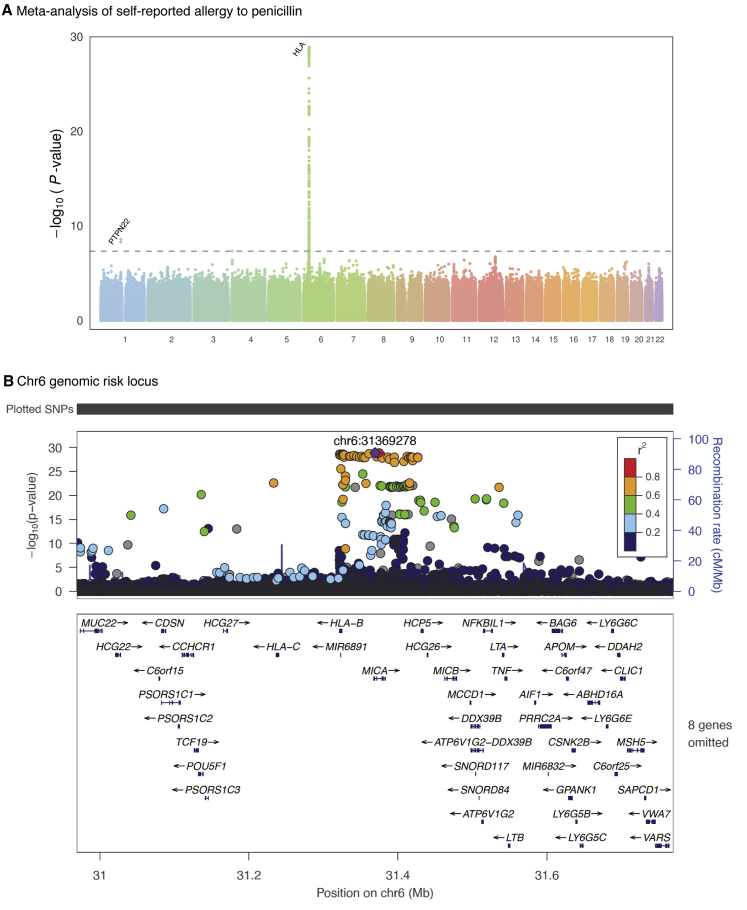
Manhattan Plot and HLA Locus of the Genome-wide Association Study of Penicillin AllergyThe X axes indicate chromosomal positions and Y axes −log10 of the p Values.(A) Each dot represents a single-nucleotide polymorphism (SNP). The dotted line indicates the genome-wide significance (p value < 5.0 × 10−8) p value threshold.(B) SNPs are colored according to their linkage disequilibrium (LD; based on the 1000 Genomes phase3 EUR reference panel) with the lead SNP. The SNP marked with a purple diamond is the lead SNP rs114892859.